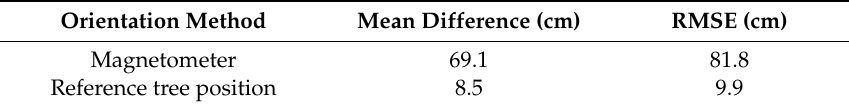
The result from comparing the archived tree position accuracy with two different orientation